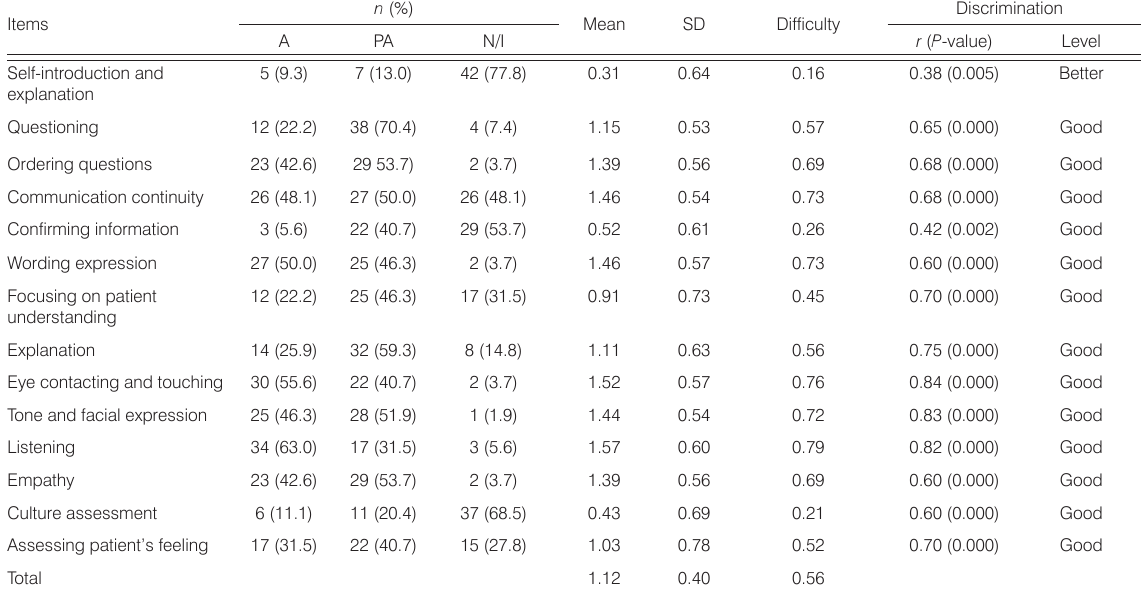
Table 4. Score description of communication skills in OSCE ( N =